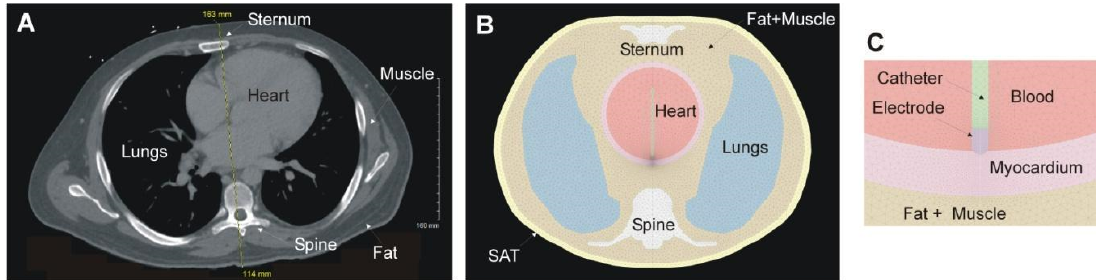
Figure 2. ( A ) CT-scan slice from a representative patient. ( B ) Computer model (units in mm) of posterior RFCA inspired by the CT-scan image and including the most representative organs. ( C ) Zoom of the RF catheter and cardiac wall.